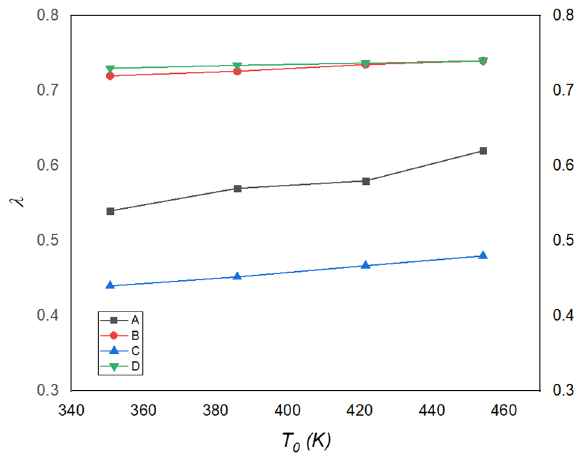
Figure 6. Emissivity results of each analysis